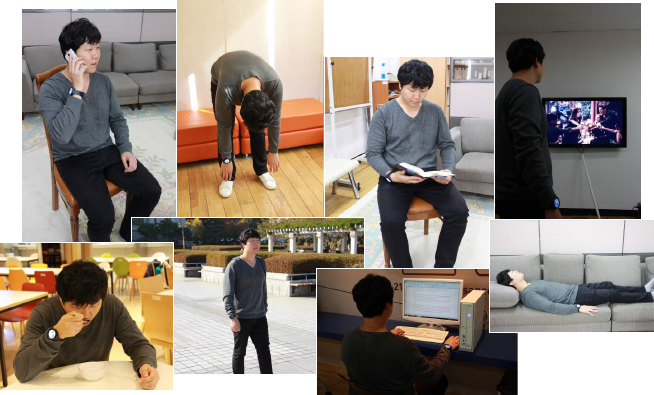
Figure 4. Examples of some of the low-level contexts collected as part of the multimodal context mining dataset.